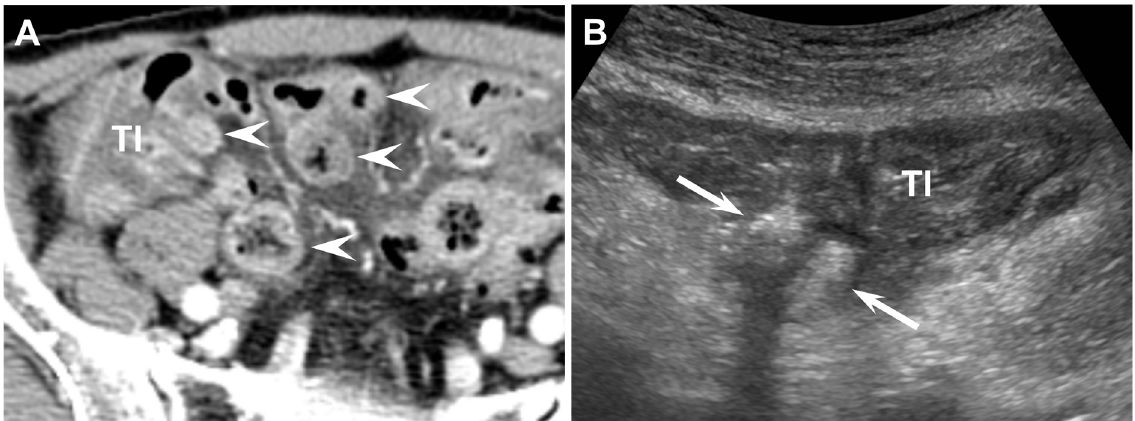
Figure 3. Seventy-eight-year-old male (patient #4) with acute ileal diverticulitis. ( A ) Enhanced axial CT scan shows multiple ileal diverticula (arrowheads) with or without fecalith, ileal wall thickening (TI), and mesenteric fat in fi ltration. ( B ) US scan with C5-1 convex transducer demonstrates two out- pouching diverticular sacs (arrows) with central hyperechoic fecalith, ileal wall thickening (TI), and increased peridiverticular fat echogenicity.